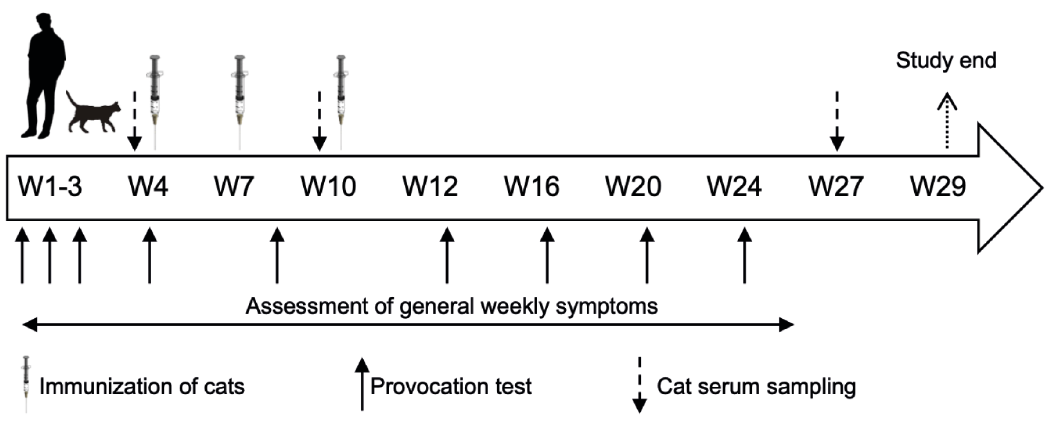
Figure 1. Study design of the combined human and animal trial. Prior to immunization of their cats, participants performed a baseline assessment of their allergic symptoms using the HypoScore (OSSS and petting time) and GWSS. In the course of the study, they performed the provocation test every four weeks and recorded their general symptoms weekly without provocation using the GWSS.